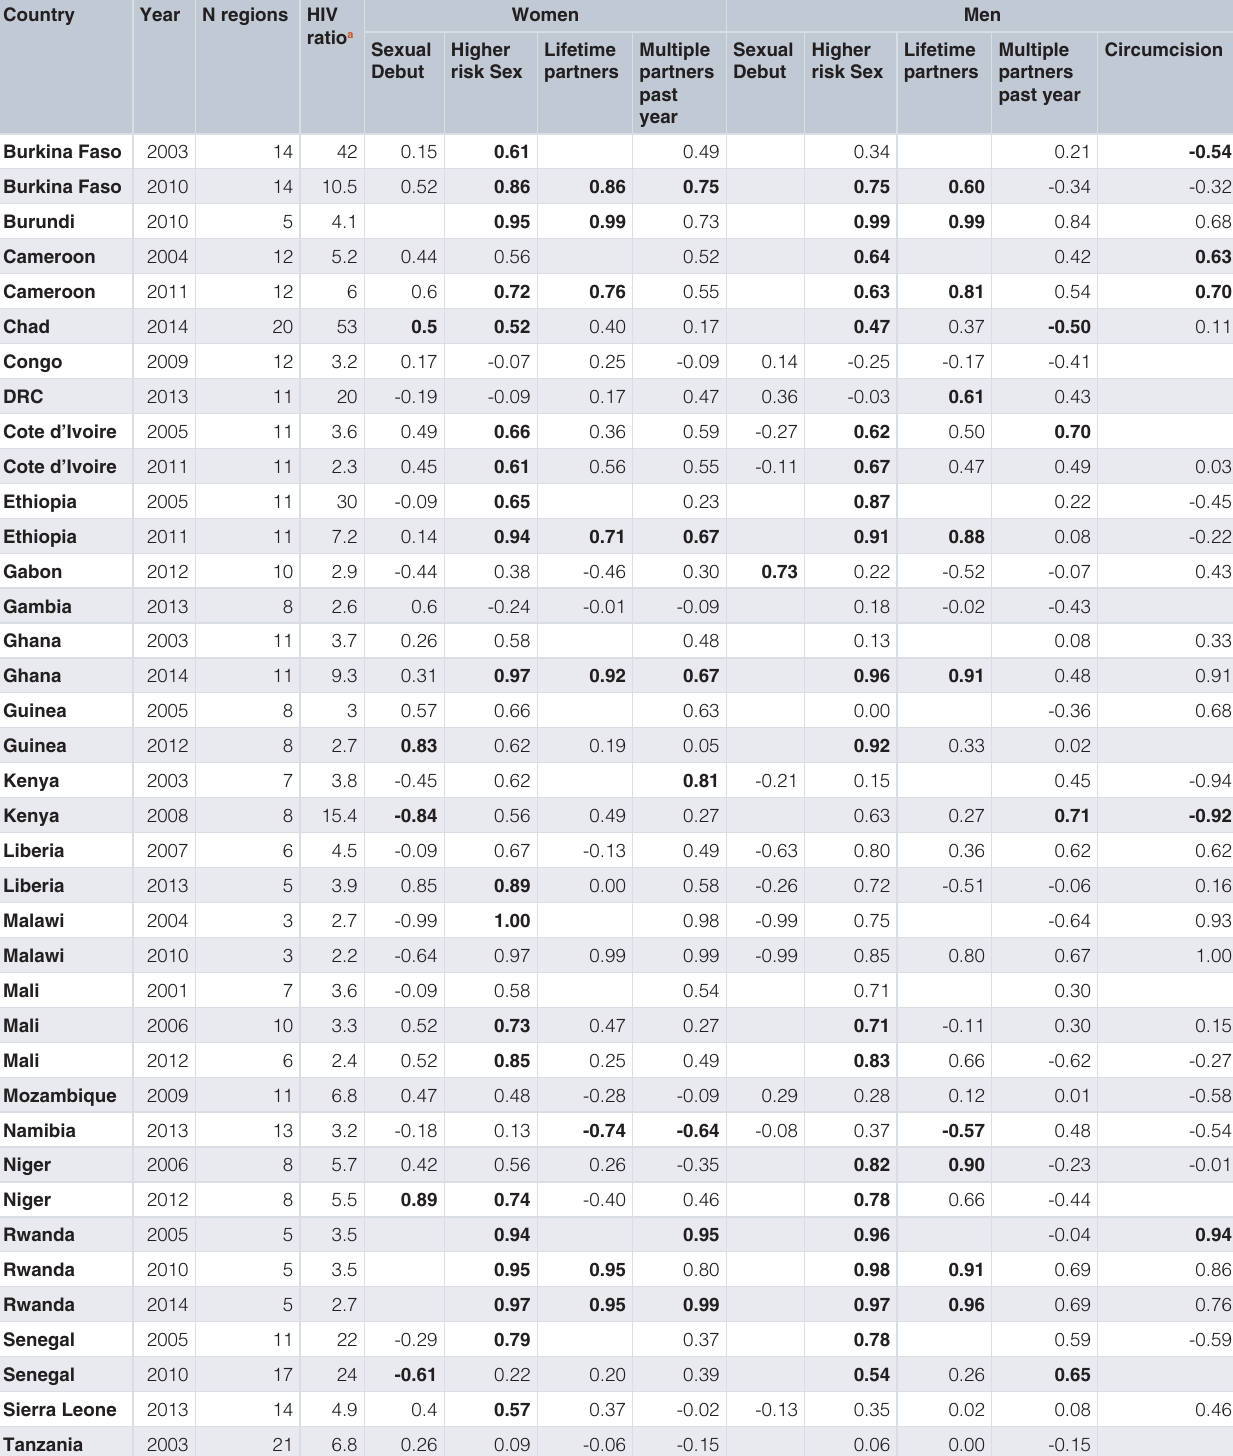
Table 1. Correlations between HIV prevalence and risk factors in 47 sub-Saharan African Demographic Health Surveys.